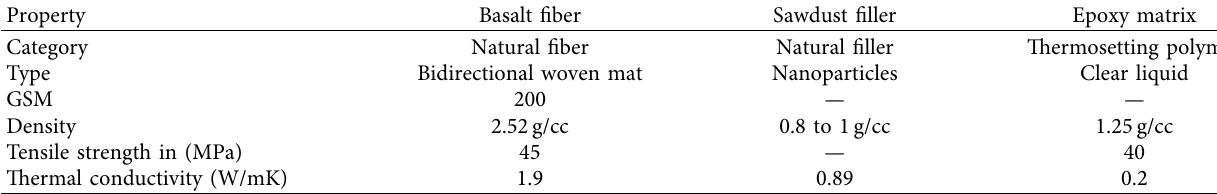
Table 1: General properties of materials used in the present work.